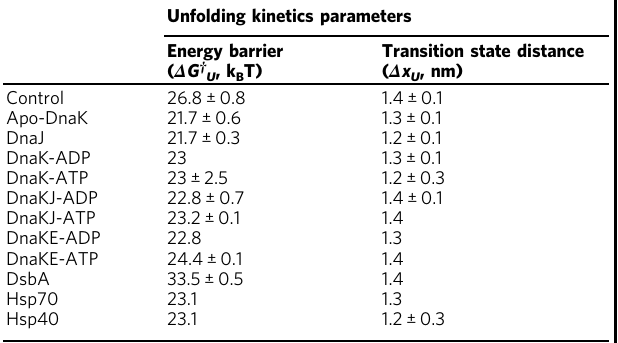
The unfolding kinetics parameters are obtained by fi tting the unfolding rates to Bell model (see Figs. 4 and 6). Δ G † U represents the height of the unfolding free energy barrier and Δ x U is the distance from the folded state to the unfolding transition state along the reaction coordinate. Data points are calculated using more than four individual molecules per force. Errors bars are represented as